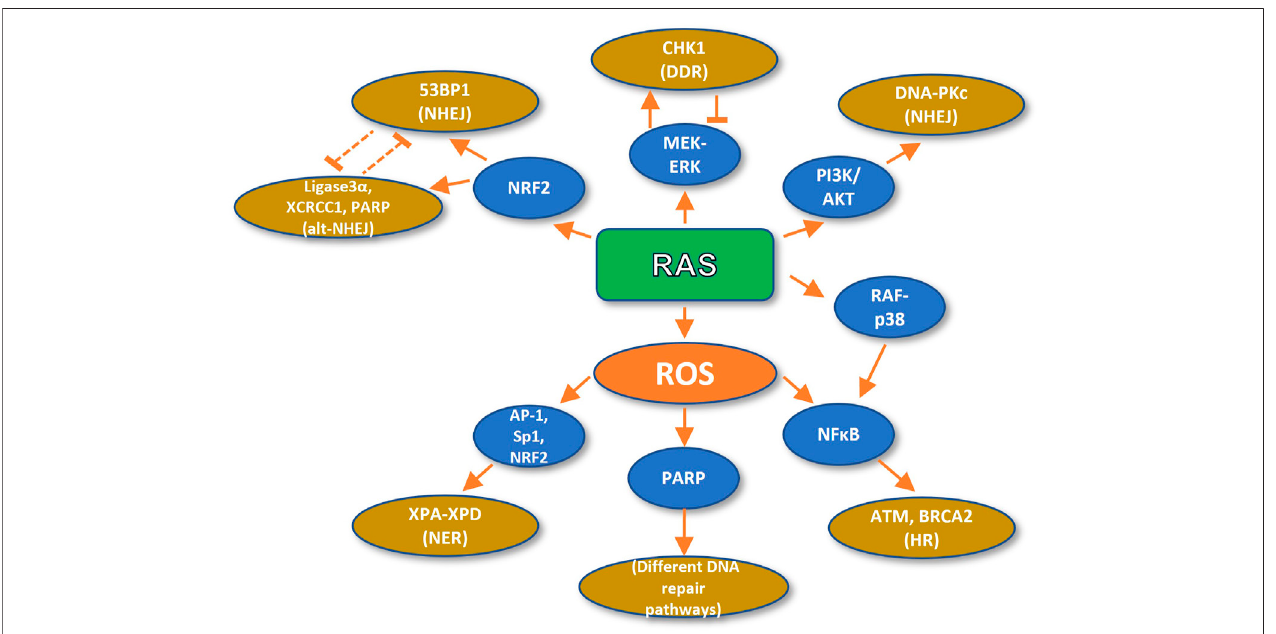
FIGURE2| Oncogenic RAS promotes DNA repair.RAS-dependent ROSformationstimulates DNArepair (HR and NER)and theDDR bythe activity ofNFkB,AP- 1, Sp1, and NRF2 transcription factors and PARP activation. On the other hand, RAS fosters DNA repair (NHEJ and alt-NHEJ) directly through activation of MEK, PI3K, and p38 pathways and the NRF2 transcription